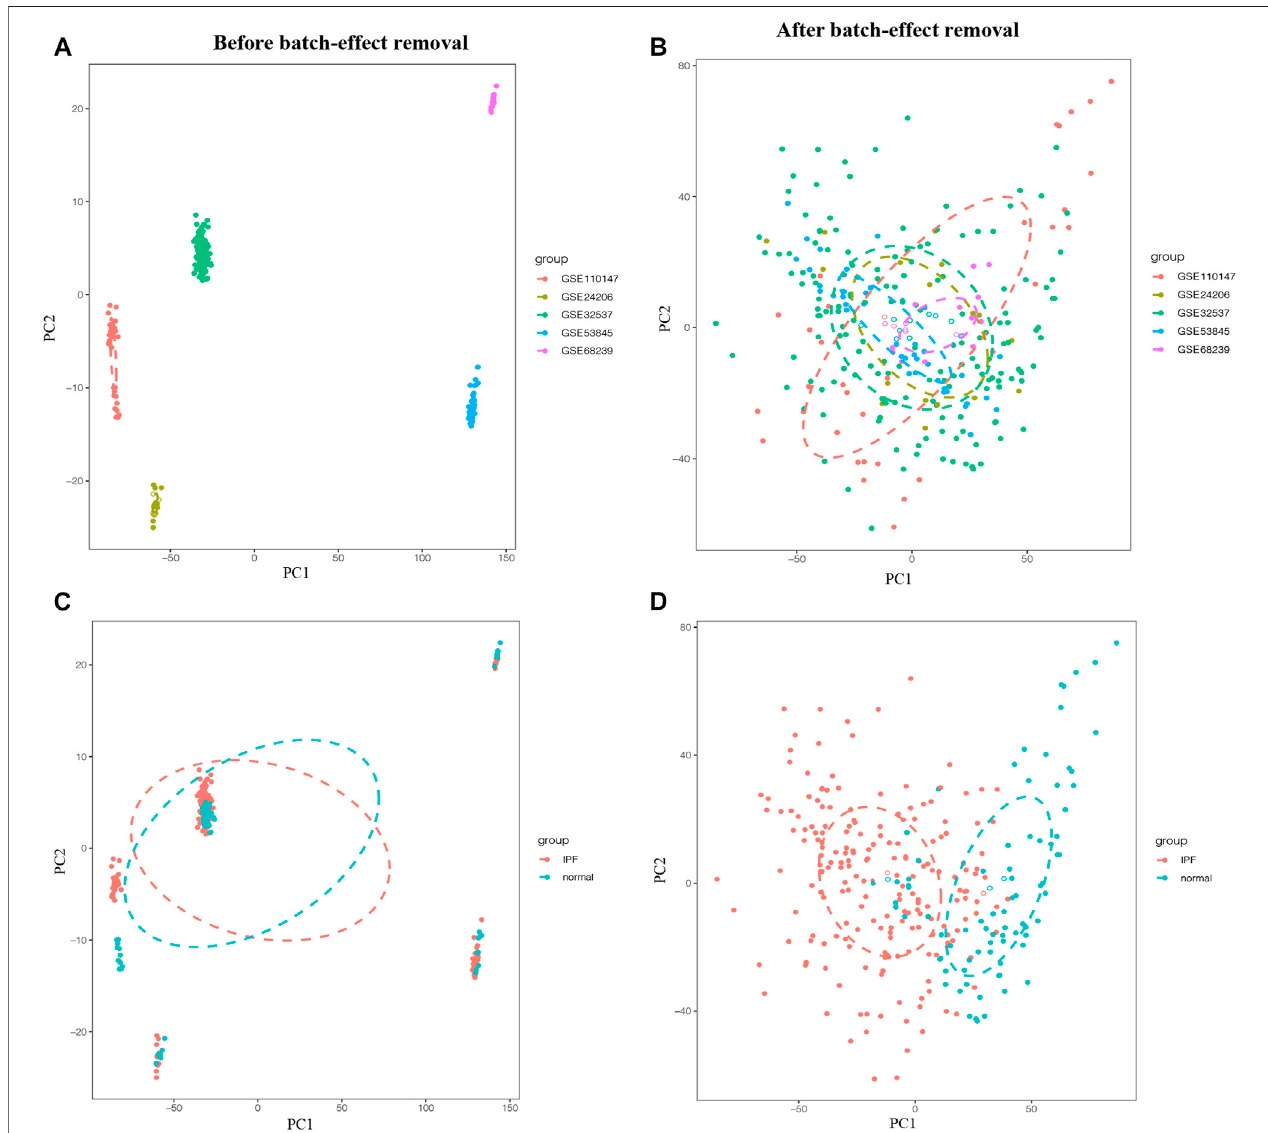
FIGURE 1 | Principal component analysis (PCA) of the training group. The points of the scatter plots represented the samples without (A,C) and with (B,D) the removal of batch effect based on the top two principal components (PC1 and PC2) of gene expression pro fi les. Samples from fi ve different datasets were color coded (A,B) , and the colors represented the IPF group and the normal group, respectively (C,D) .